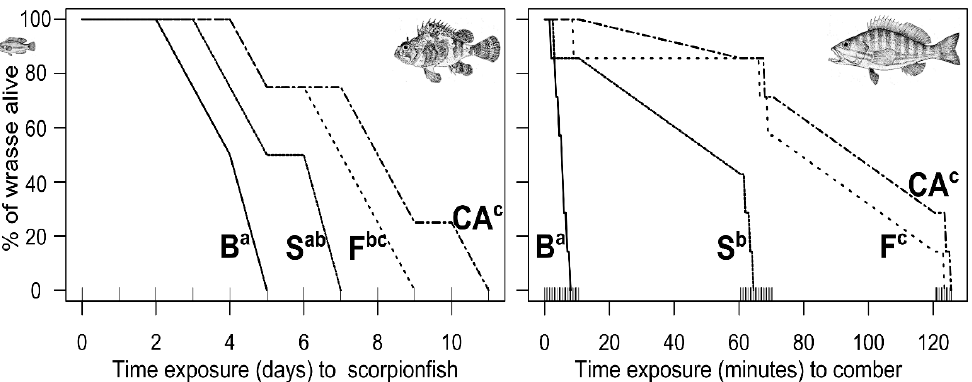
Figure 2. Survival curves of wrasse depending on habitat types and predator identity. Wrasse were exposed to scorpionfish ( left ) and to comber ( right ) in the habitats of increasing complexity: Barren (B), Shrub (S) and Forest (F), and in the Choice Arena (CA). In each graph, curves sharing a lowercase letter were not significantly different. Upper tick marks on the axis X delimits the censored intervals.